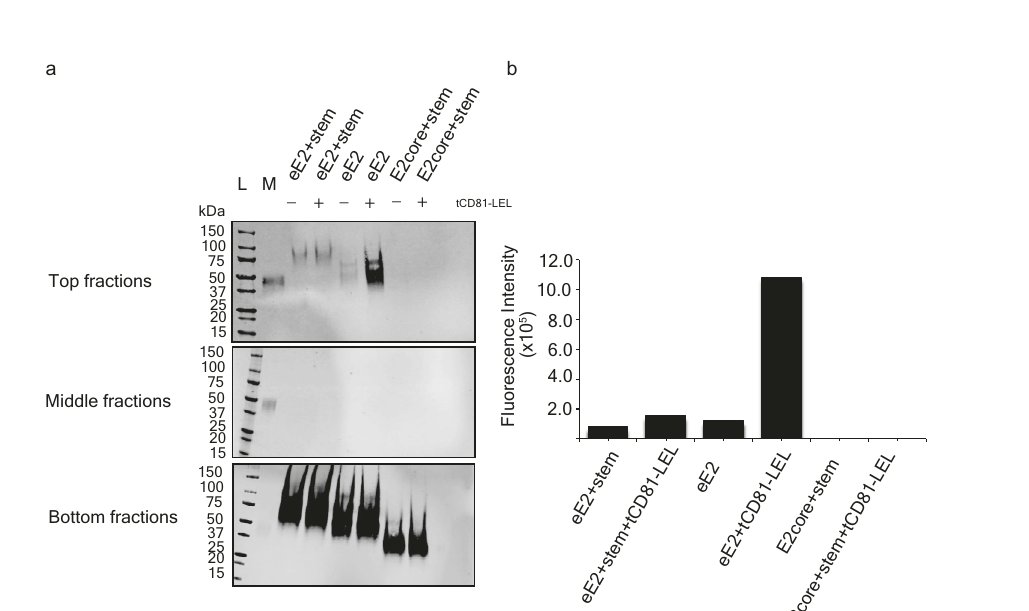
bilayer, and representative phospholipids are docked into the bilayer and shown as cyan heteroatom sticks. Ribbon diagrams of CD81-LEL (sky blue) and CD81-binding loop of extended ( Δ HVR1 eE2) and bent (E2core+stem) structures are shown in greenandred,respectively. b Thepanelisamagni fi cationoftheCD81-bindingloop and part of the membrane showing the relative distances (dotted lines) of Tyr529 and Trp531 from the hydrophobic membrane core are